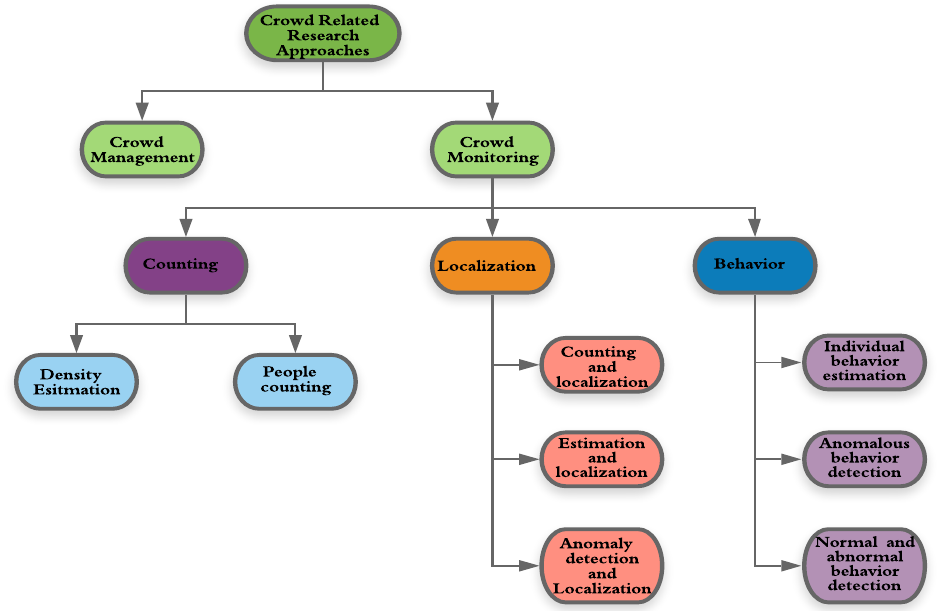
Figure 1. ( a ) The list of research papers published in web of science and scopus on crowd monitoring from 2014–2019 while ( b ) shows machine learning on crowd monitoring